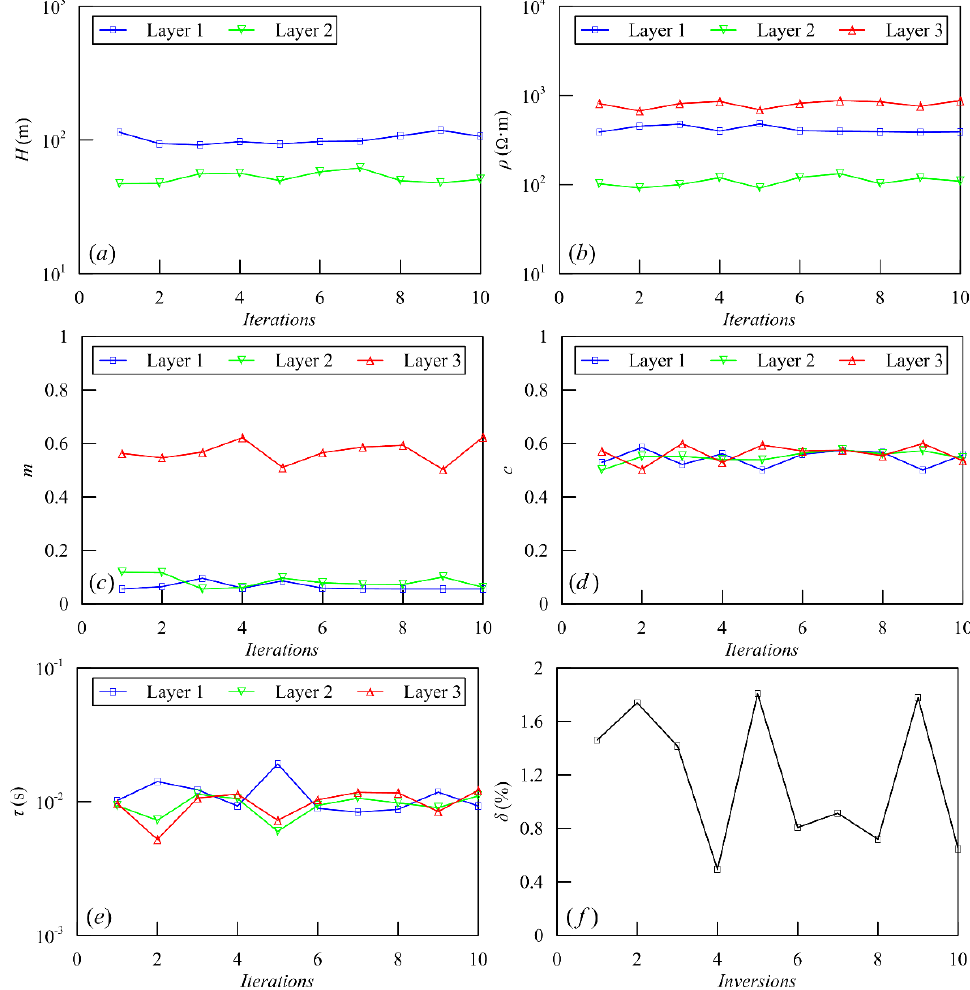
Figure 6. The inversion parameters of Model 3 using dual source. ( a ) The layer thickness; ( b ) The resistivity; ( c ) The chargeability; ( d ) The frequency exponent; ( e ) The time constant; ( f ) The relative fitting error.